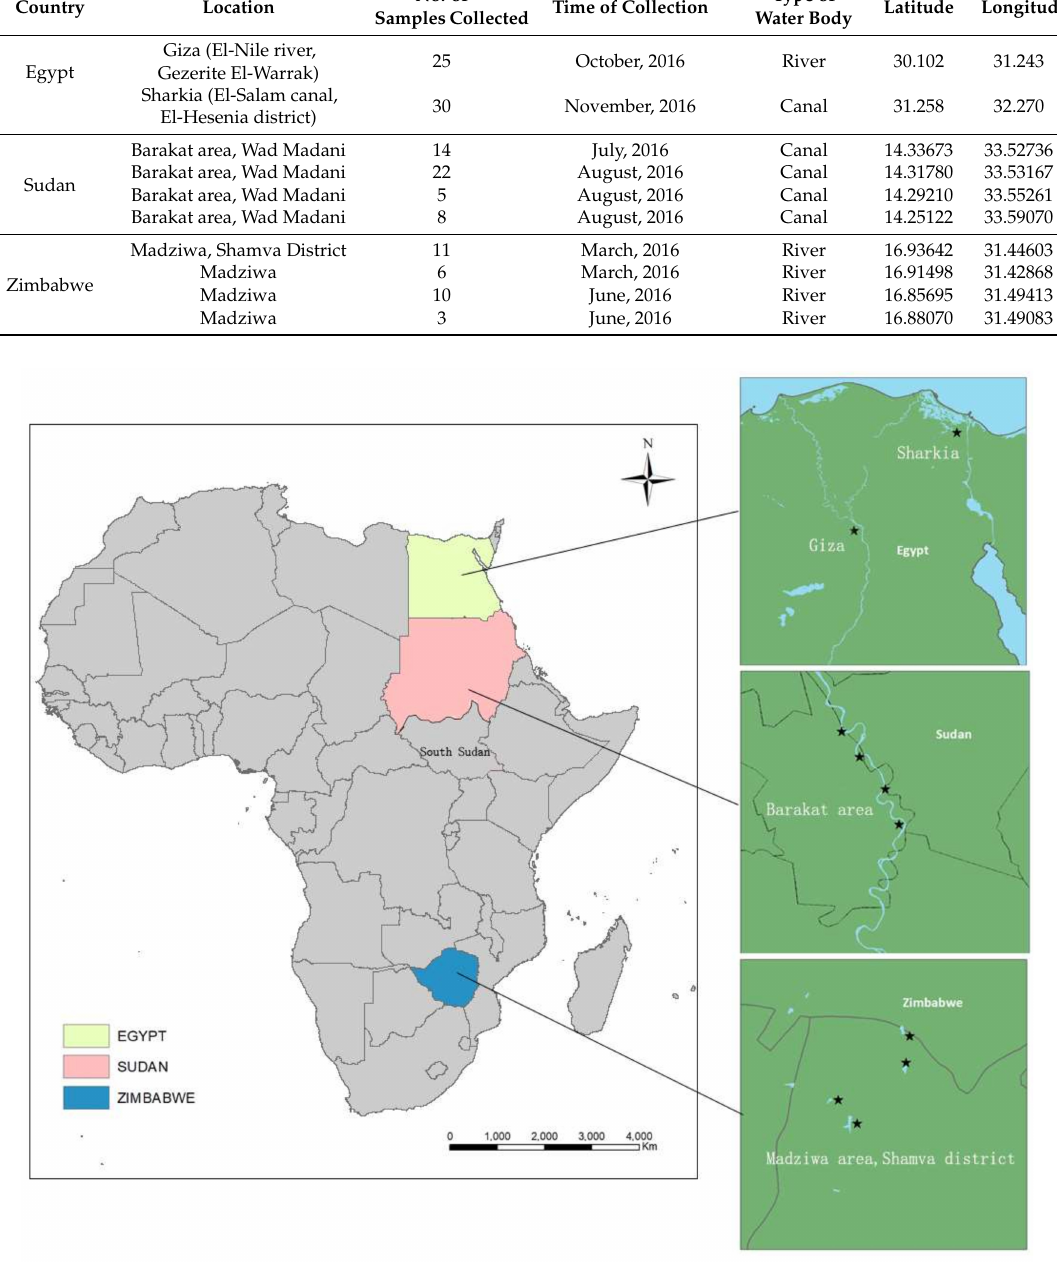
Figure 1. Map of Africa showing countries where snail samples were